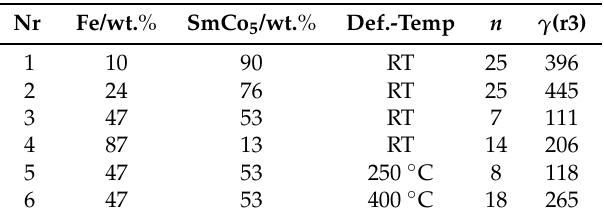
Figure 1. Schematic illustration of a halved HPT-deformed disc. The positions of SQUID-samples at varying radii are outlined (green boxes) with respect to the used cutting directions. Exemplarily axial XRD (yellow) and tangential SEM (turquoise) measurements are indicated. Table 1. Summarised processing parameters of used samples in this study. n depicts the number of torsions and γ (r3) the shear strain at radius = 3